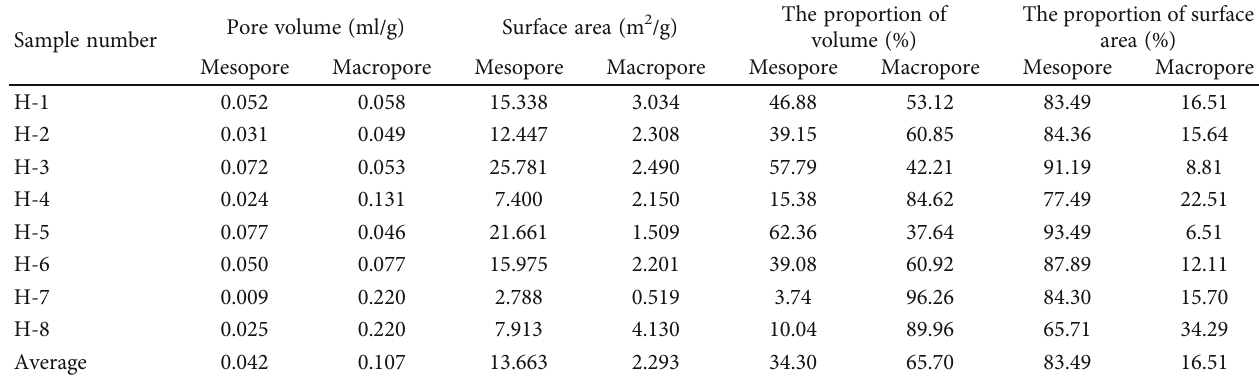
Table 2: Pore volume and speci fi c surface area of mudstone of Qigequan Formation. Sample